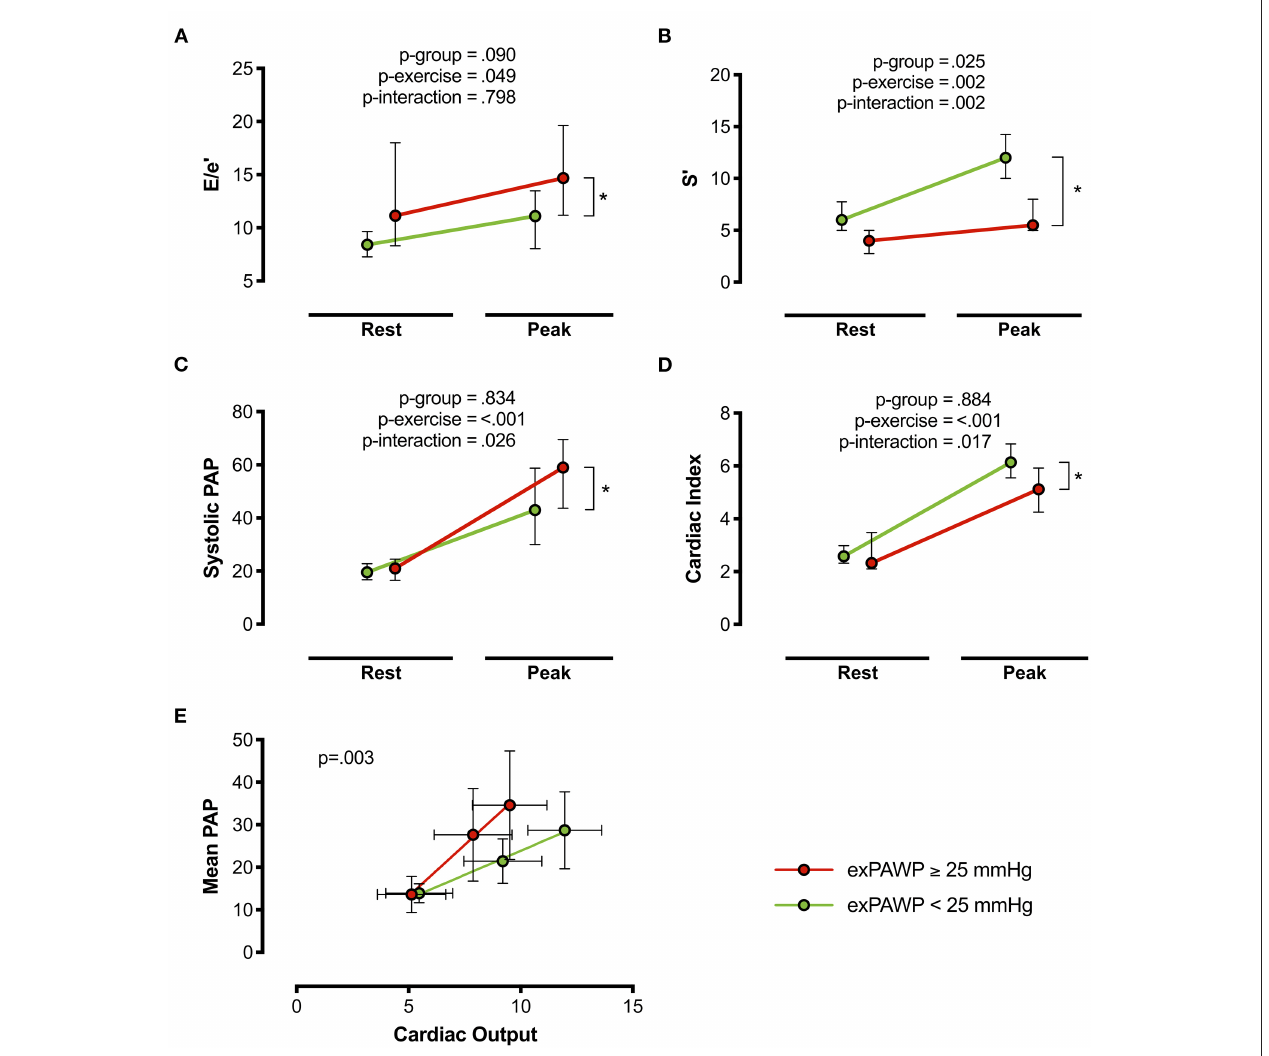
FIGURE 2 | DST parameters associated with elevated exPAWP. Results of non-invasive septal E/e’ (A) , S’ (B) , systolic PAP (C) , cardiac index (D) , and mean PAP/CO slope (E) in the exRHC cohort at rest and peak exercise. Red: patients with elevated exPAWP ( n = 14), green: patients with normal exPAWP ( n = 8). P -values from linear mixed models. * p < 0.05 in multiplicity-adjusted comparison of peak values. exPAWP, pulmonary artery wedge pressure during peak exercise; PAP; pulmonary artery pressure.